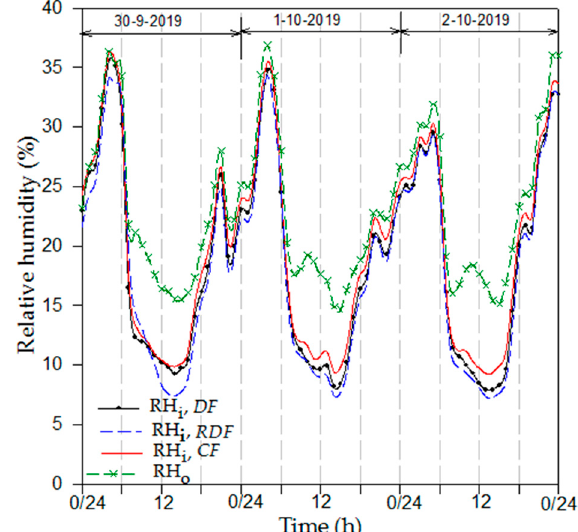
Figure 11. Time courses of the air relative humidity inside the greenhouse models covered with the DF , RDF , and CF films and outside the models.